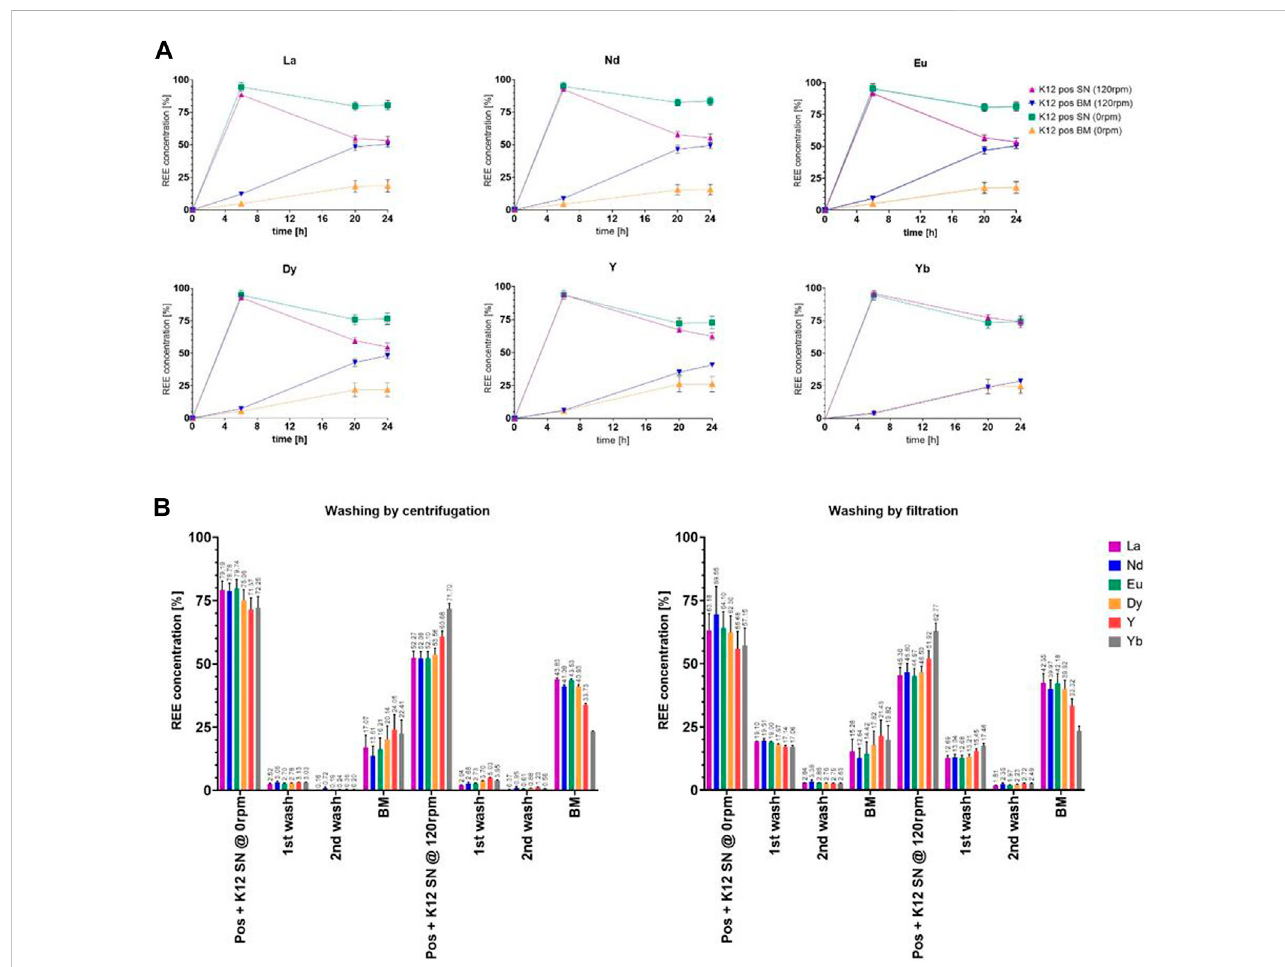
FIGURE 8 (A) Comparisonoftheuptakeofsixchosenelementsastherepresentationofthefullsetoflanthanides( Y -axis:percentageofthetotalconcentration[%]; X -axis:time[h]). (B) Analysismeasurementsoftheuptakeofsixchosenelementsaftereachwashingstepinthepercentageoftotalretrieval.Allmeasurements are given as percentages of the calculated fi nal concentration of 2.25